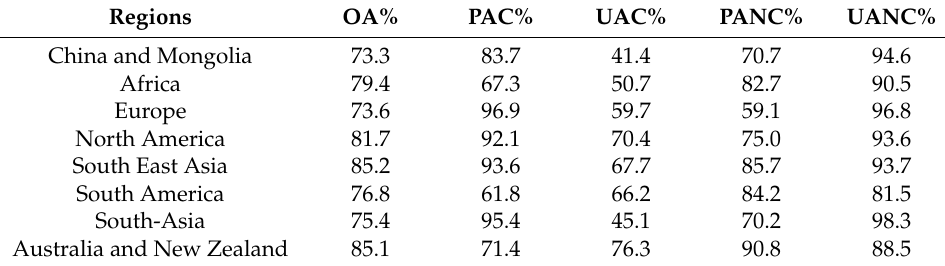
Table 7. The accuracy measures of GFSAD1km map in eight regions.